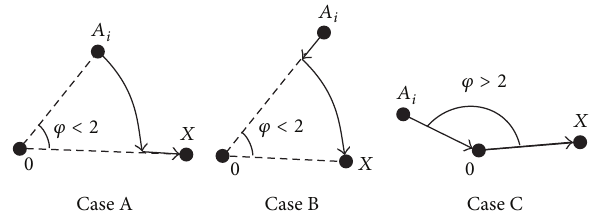
Figure 2: Various paths in case of control Strategy